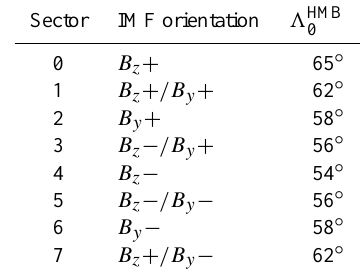
Table 2. Reference latitude of the Heppner-Maynard boundary (HMB) for each of the 8 IMF sectors. The HMB is characterized here by its magnetic latitude 3 HMB at midnight. The different HMB 0 extensions are congruent in shape; they are circular on the nightside but withdraw to higher latitudes on the